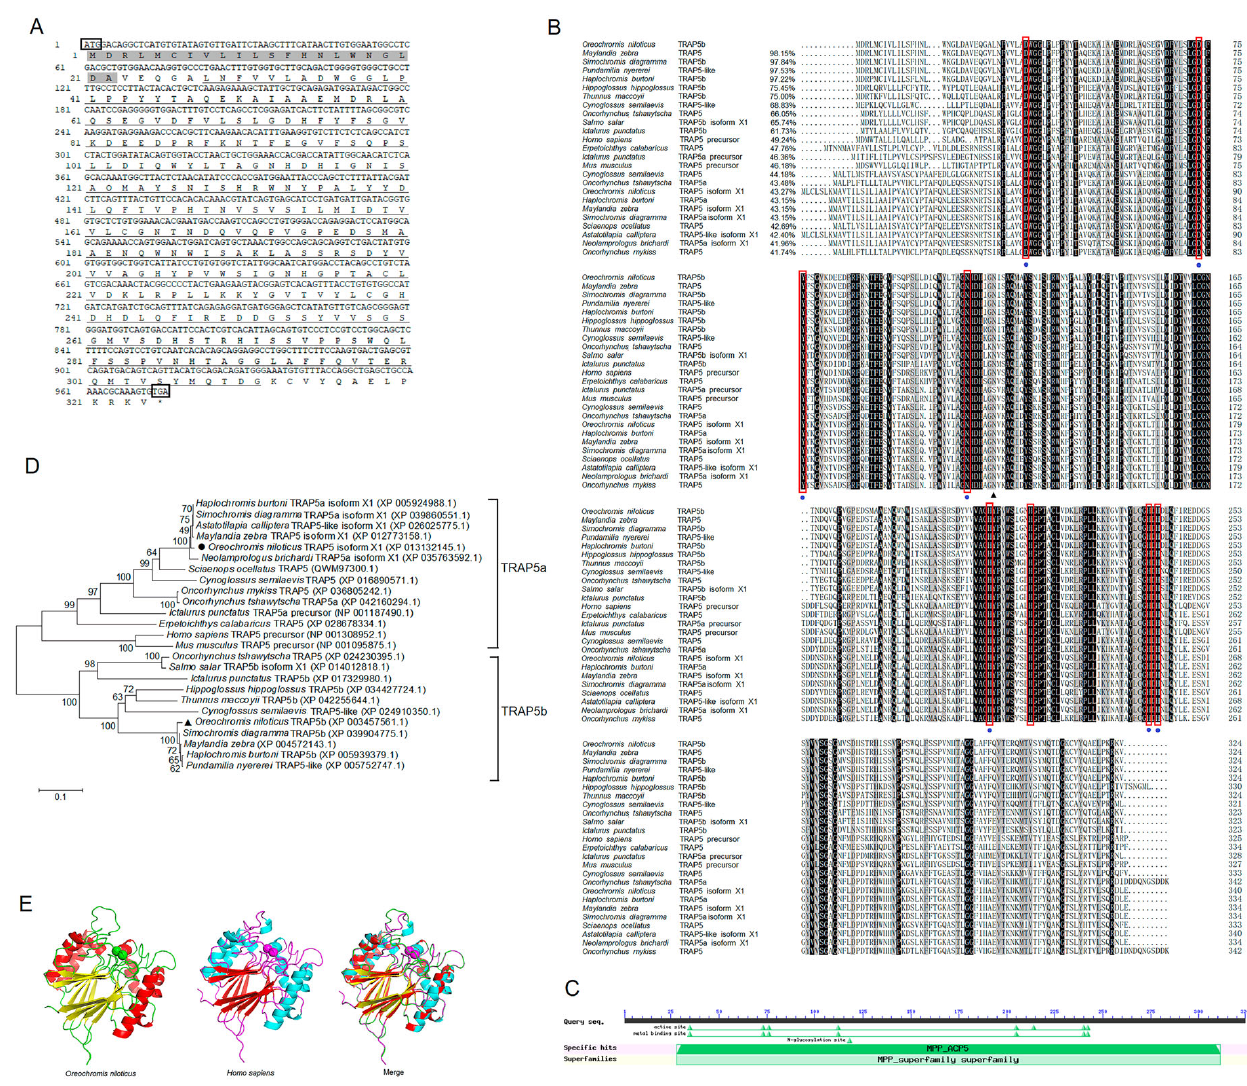
Figure 1. Structure and sequence analysis of TRAP5b from Nile tilapia. ( A ) The nucleotide and deduced amino acid sequences of OnTRAP5b. The signal peptide is marked in a gray shadow. The metallophosphatase domain is marked with a single underline. The translation start (ATG) and stop (TGA) codons are boxed. ( B , C ) Alignment of the predicted amino acid sequences of OnTRAP5b homologs and predicted conserved domains of OnTRAP5b. Symbol ( • ) represents metal binding sites, and active sites are in red boxed. Symbol ( (cid:78) ) represents the N-glycosylation site. The numbers indicate the sequence identities between OnTRAP5b and the compared sequences. The conserved and identical residues are represented by black shading, and the residues that are ≥ 75% identical among the aligned are in gray. ( D ) Phylogenetic tree analysis of OnTRAP5b among other vertebrates. A neighbor-joining phylogenetic tree of TRAP5 proteins based on protein sequence analyzed with mega 6.0. The degree of confidence in each branch point was determined by bootstrap analysis (1000 times). ( E ) The predicted three-dimensional structure of protein TRAP5b from Oreochromis niloticus ( left ), Homo sapiens ( middle ), and overlapped three-dimensional structure of TRAP5 from them ( right